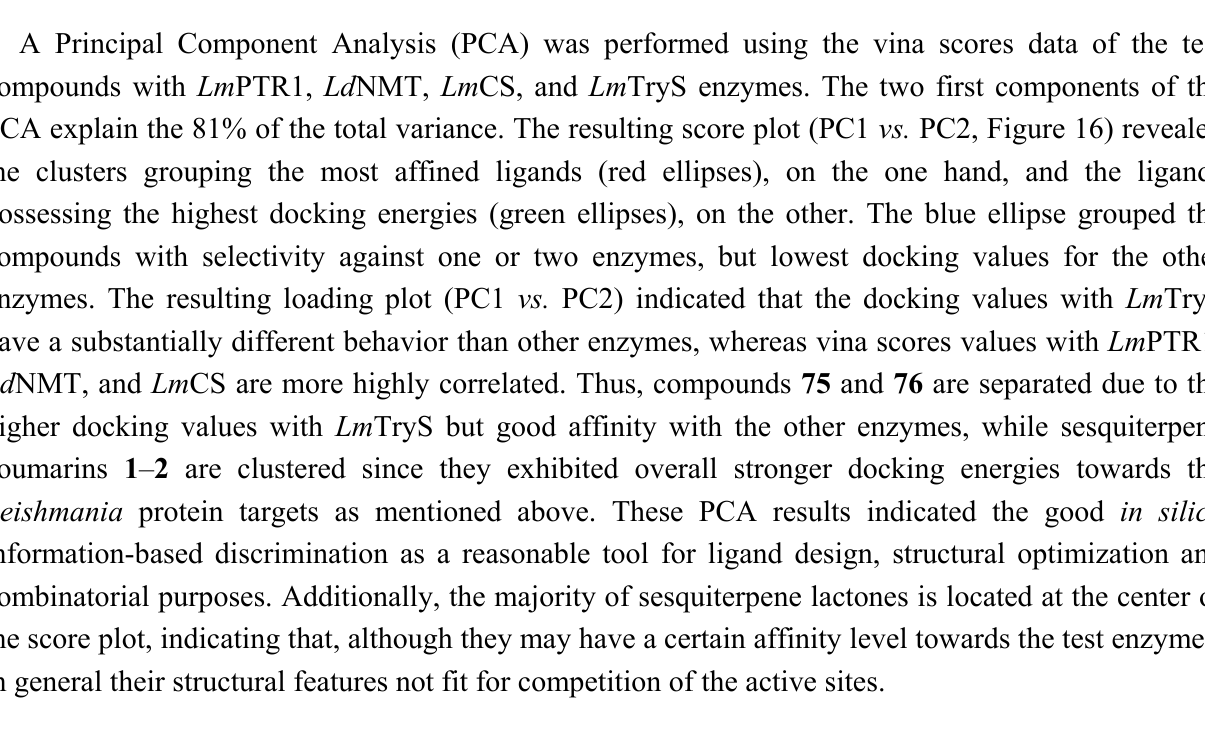
Figure 16. Principal Component Analysis for the docking energies of test compounds